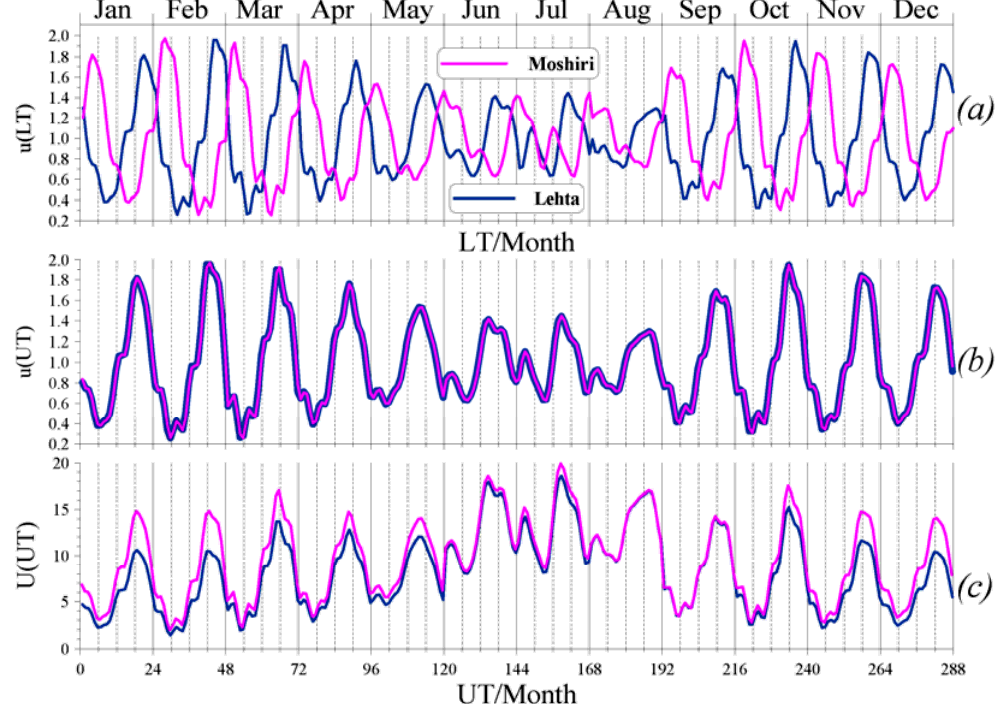
Fig. 4. Universal modulation functions: the normalized – u ( UT ) and the “absolute” – U ( UT ) obtained from the Lehta and Moshiri model data with a series of five terms.